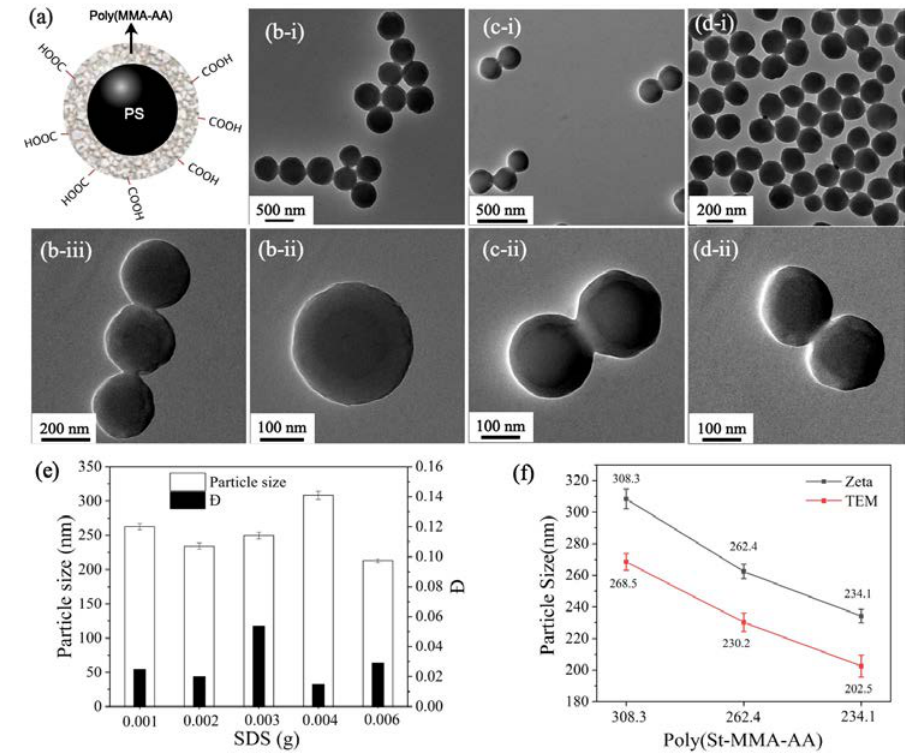
Figure 2. ( a ) Schematic representation of the structure of Poly(St-MMA-AA) nanoparticle with PS core and Poly(MMA-AA) shell structure; ( b – d ) transmission electron microscopy (TEM) images of Poly(St-MMA-AA) with various hydrodynamic diameters of ( b ) 308.3 nm, ( c ) 262.4 nm and ( d ) 234.1 nm with di ff erent magnification of ( b - i ) 5000 × , ( b - ii ) 40,000 × , ( b - iii ) 20,000 × , ( c - i ) 8000 × , ( c - ii ) 30,000 × , ( d - i ) 10,000 × , ( d - ii ) 30,000 × ; ( e ) di ff erent Poly(St-MMA-AA) particle sizes of 262.4, 234.1, 249.7, 308.3, and 213.1 nm successively with di ff erent Ð values of 0.025, 0.020, 0.054, 0.015, 0.029, as a function of sodium dodecyl sulfate (SDS) amount of 0.001 g, 0.002 g, 0.003 g, 0.004 g, and 0.006 g, respectively (from Zeta particle sizer); ( f ) particle size contrast of Poly(St-MMA-AA) nanoparticles measured by Zeta analyser and by Nano measurer 1.2 software from TEM